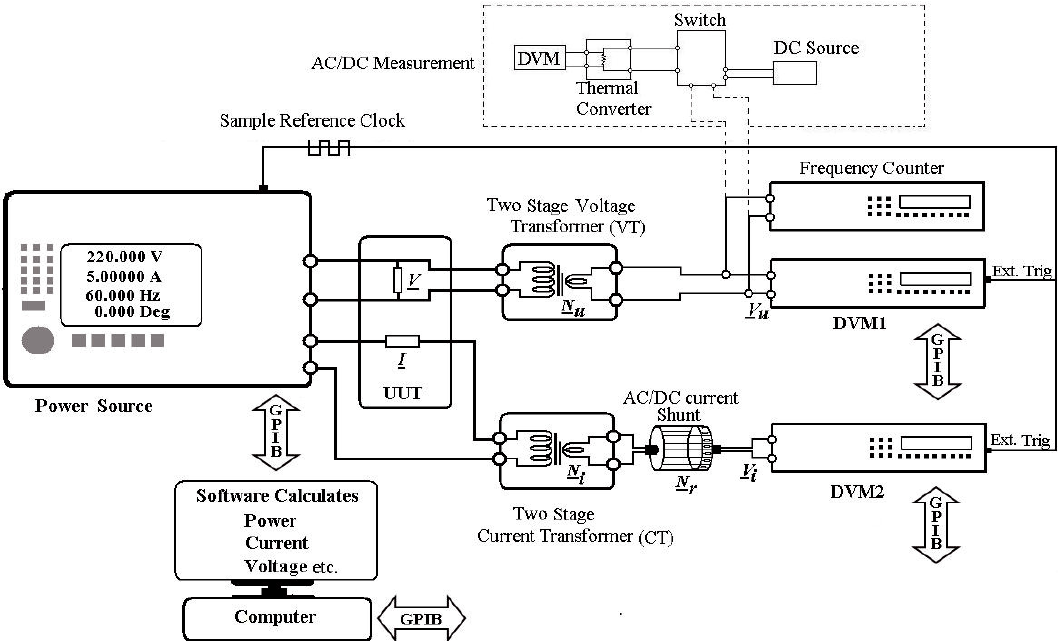
Fig. 1. Layout of the measuring system.